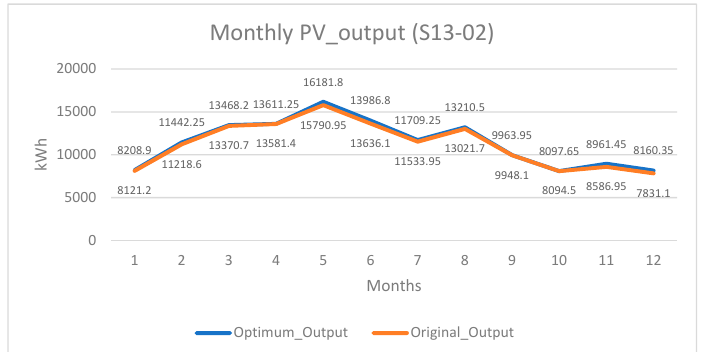
Figure A1. Monthly tilt angles and outputs of S13-02 module.